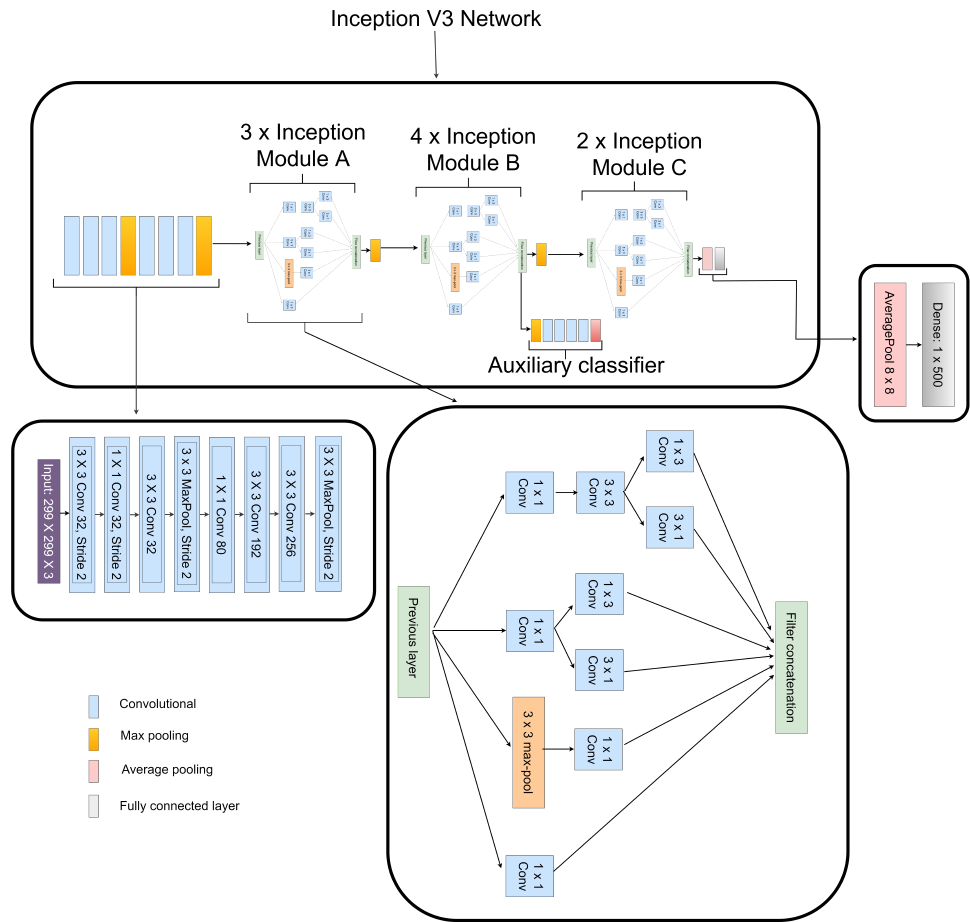
Figure 5. Structure of the fine-tuned Inception V3 network used to extract DR and non-DR related features from CLAHE fundus